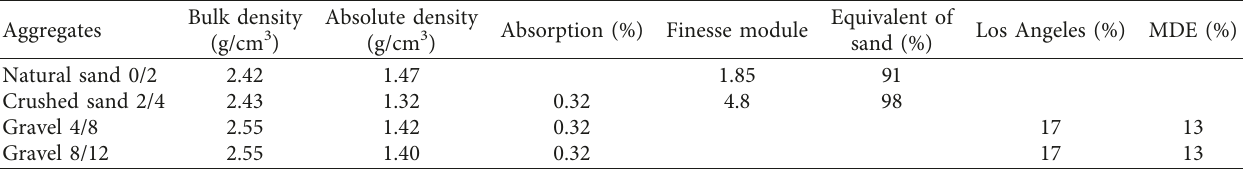
Table 4: Physical characteristics of aggregates.